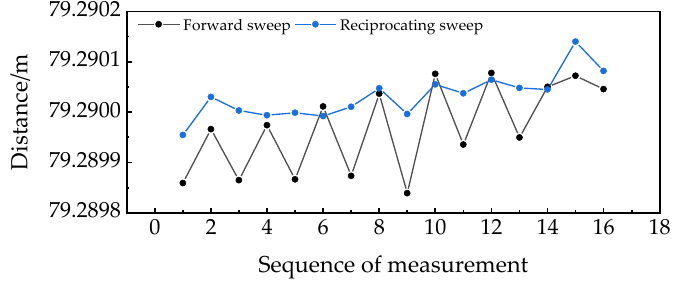
Figure 6. Measurement results under different sweep methods.